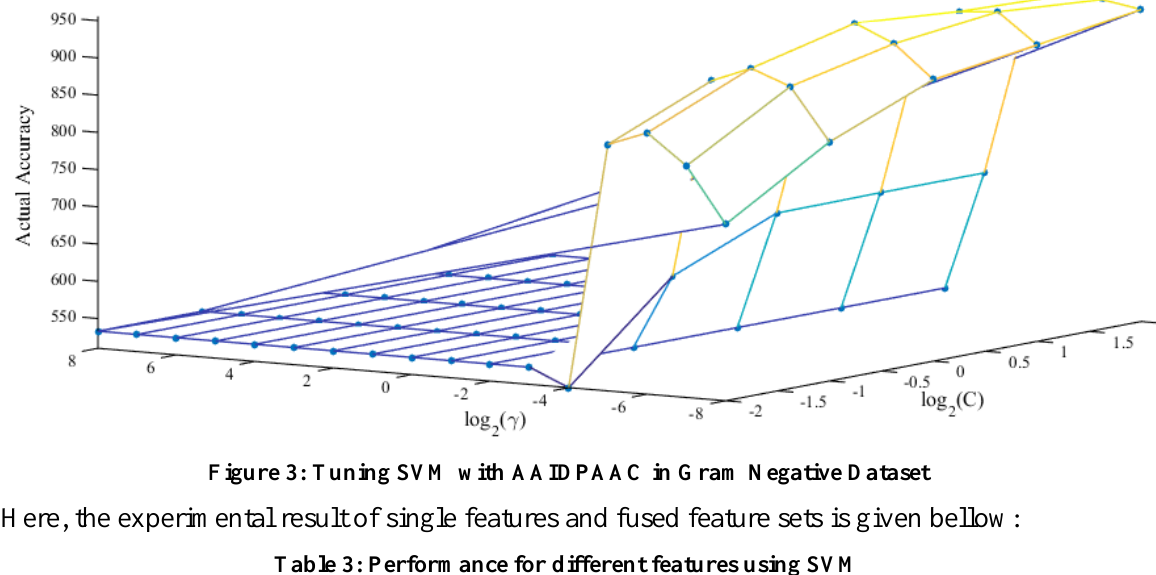
Figure 3: Tuning SVM with AAIDPAAC in Gram Negative Dataset